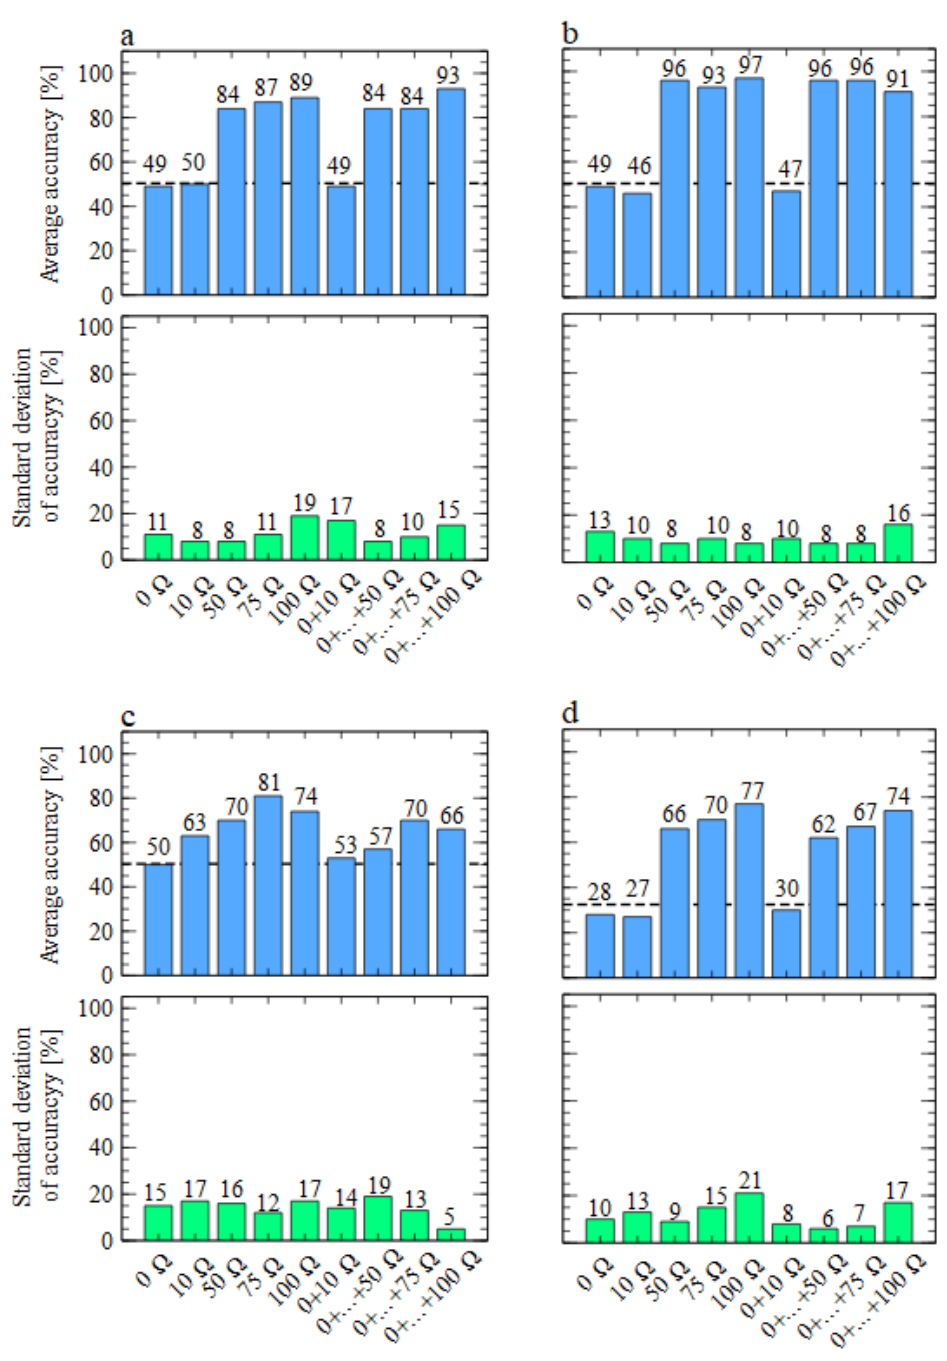
Figure 7. Performances of classification models, using data collected by the TGS 2602-type sensors with various heater voltages. Average accuracy and standard deviation of model accuracy were calculated in a cross-validation loop, as described in the main text. Binary or multinomial target classification is presented in subfigures. ( a ) Medium versus Fusarium . ( b ) Medium versus Rhizoctonia . ( c ) Fusarium versus Rhizoctonia . ( d ) Medium versus Fusarium versus Rhizoctonia . The bars represent various models built using a single sensor’s data or multiple sensors’ data, and the sensors are labelled by the resistances attached to their heaters. The horizontal line represents the null (random) model